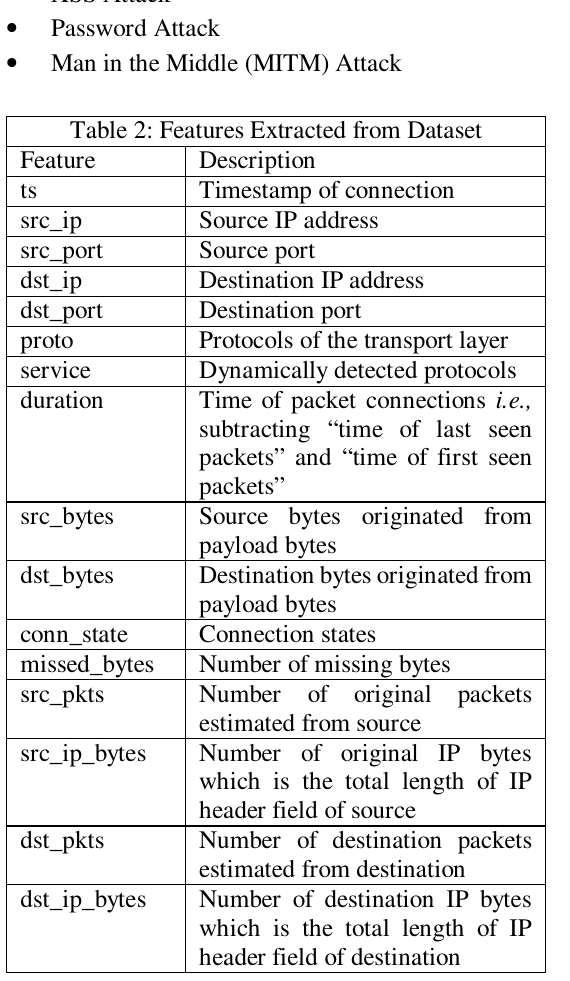
Fig.4: Malware Family Statistics